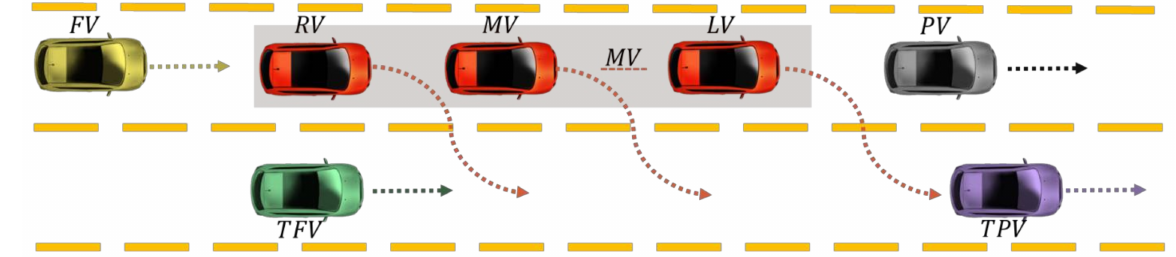
Figure 1. The typical lane-changing scenario of the platoon.